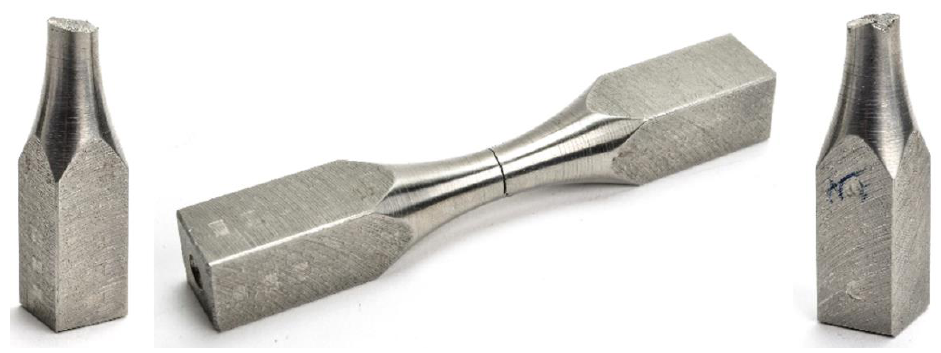
Figure 1. The real S355J2 steel specimen after fatigue test.